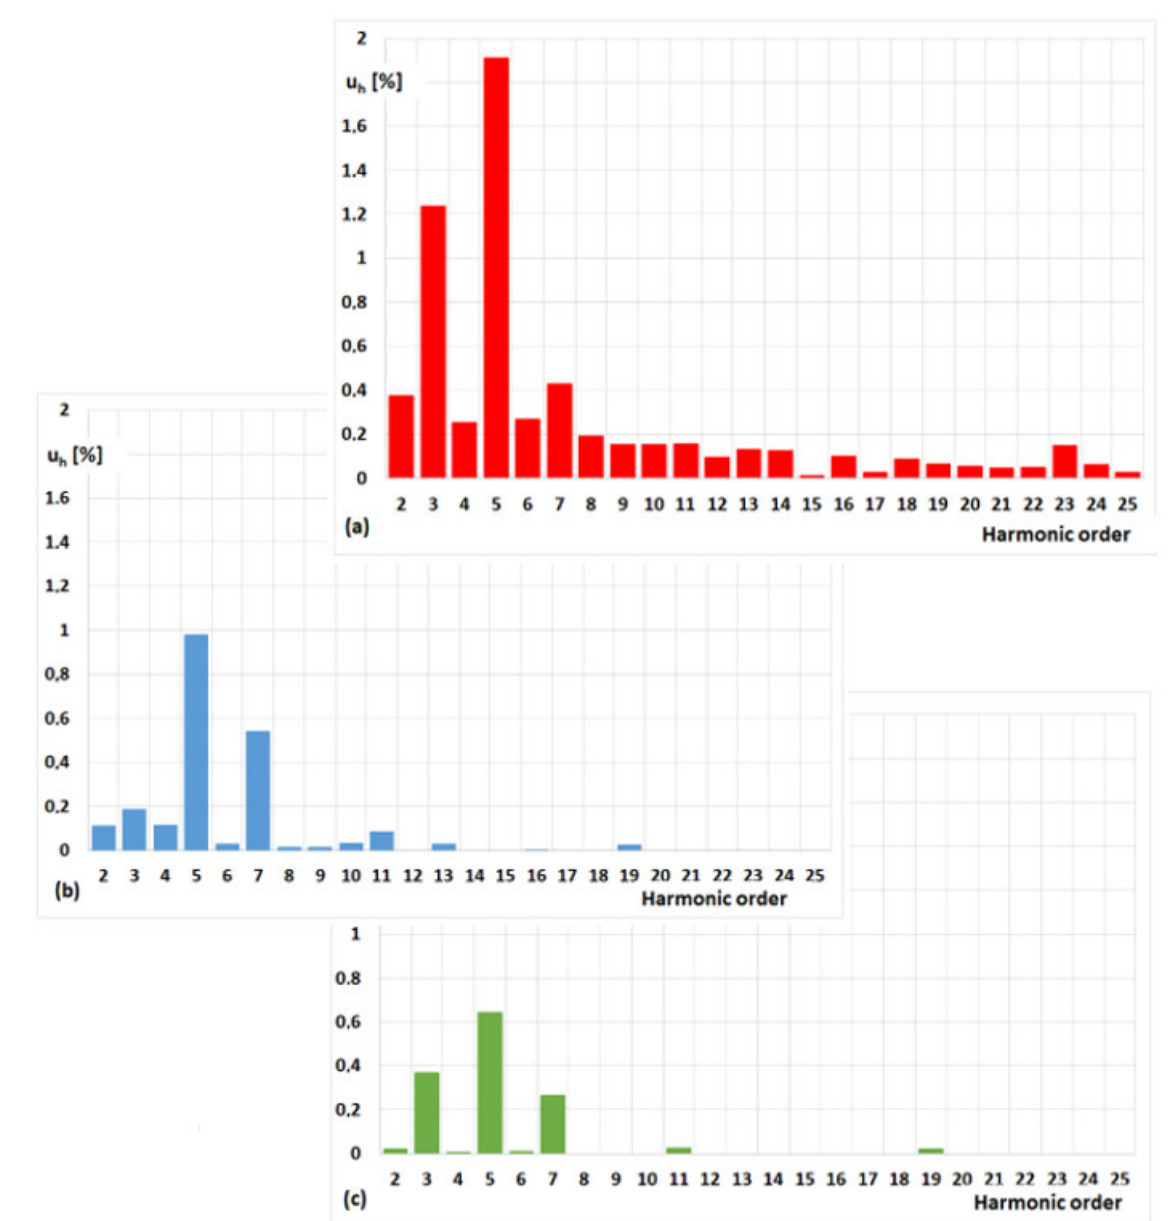
Figure 8. Spectrum of voltage harmonics in different melting phases in the arc furnace: ( a ) com- mencement of melting the charge; ( b ) melted charge; ( c ) when the furnace is turned off (loading the scrap into the furnace).